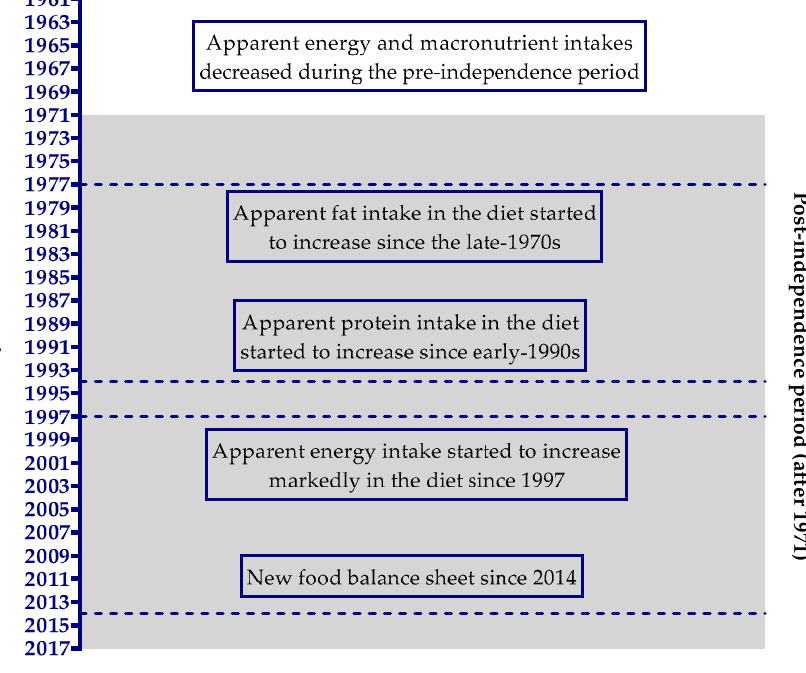
Figure 3. A brief summary of the significant changes over the periods in apparent energy and macronutrient intakes in Bangladesh from 1961 to 2017. Shaded area indicates the time after independence and the unshaded area represents the time before independence. The horizontal lines represent the year where significant changes